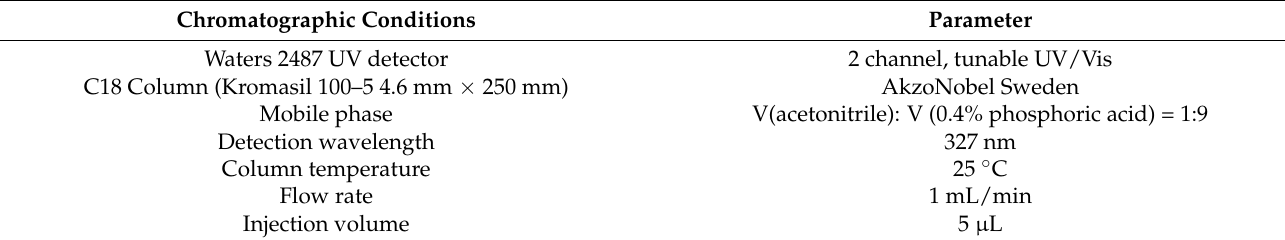
Table 2. Waters 2695 HPLC used in this